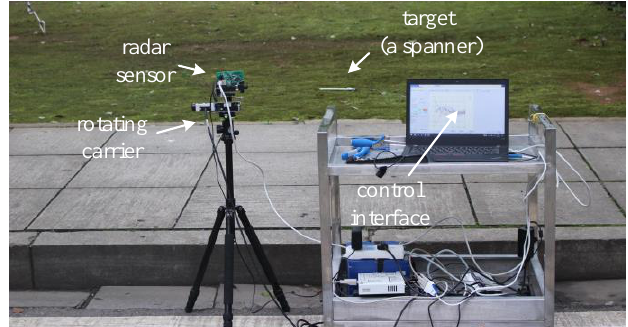
Figure 8. The scene containing a concrete pavement and the side lawn is scanned by the radar